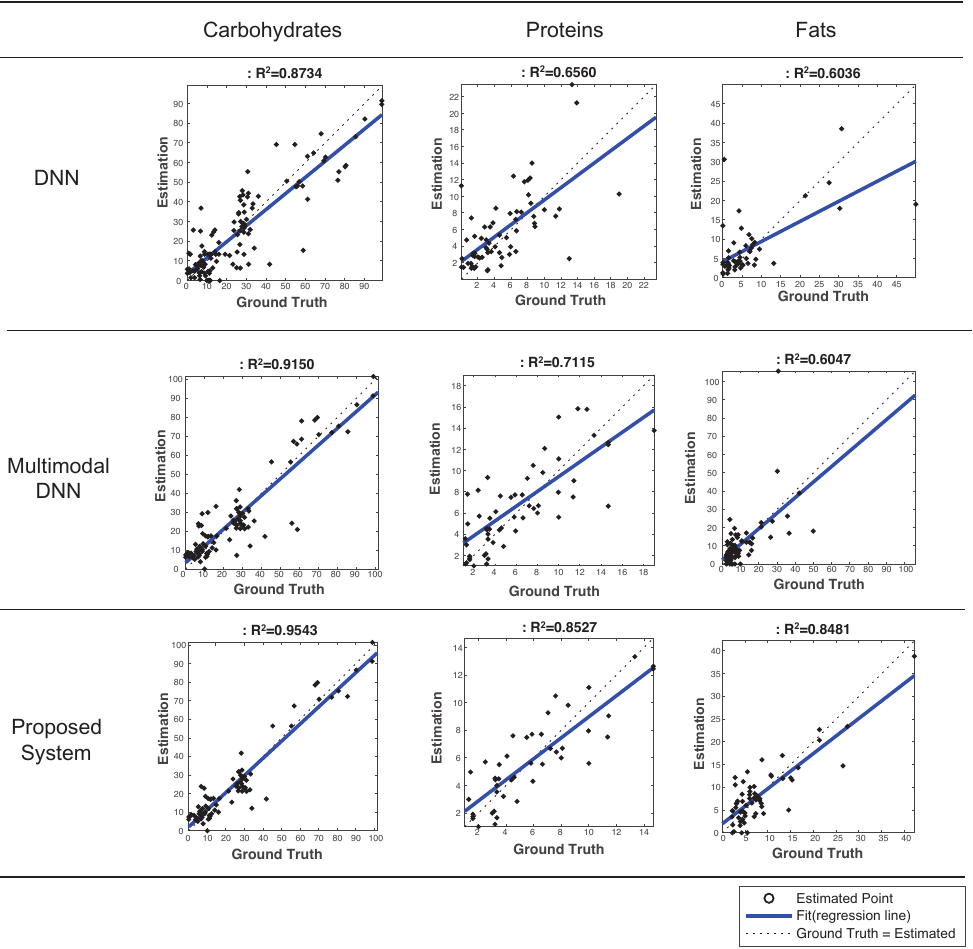
Figure 4. Evaluation of estimated vs. ground truth values as well as R 2 values in 3 systems to estimate food